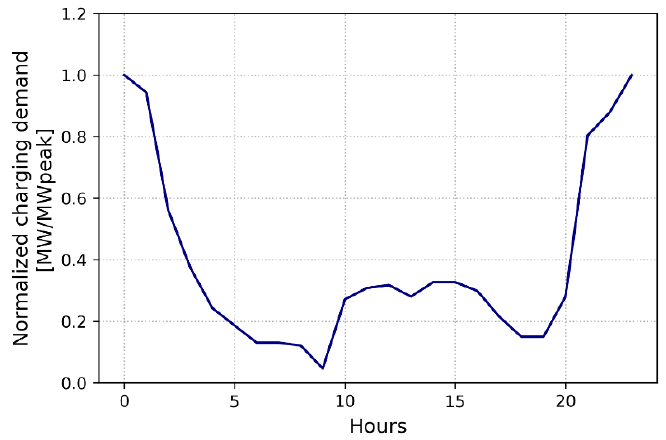
Figure 3. Hourly profile of electricity demand from electric mobility.